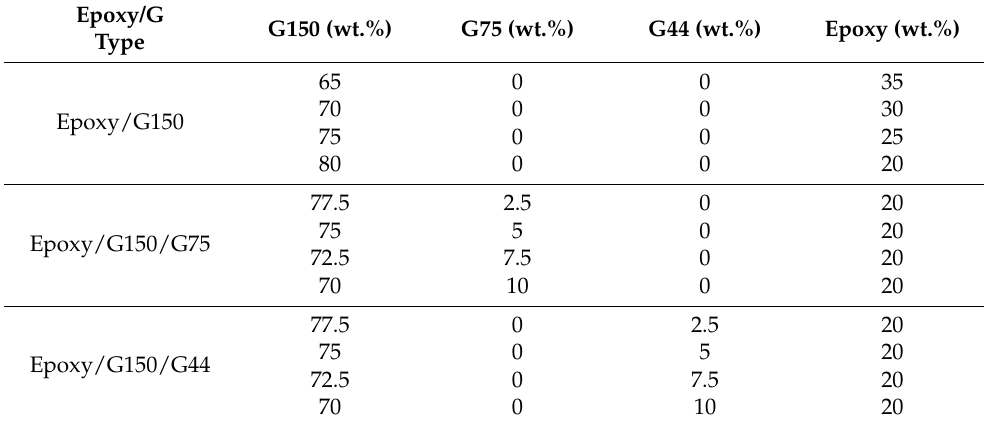
Table 1. Composition of different epoxy/G composites.